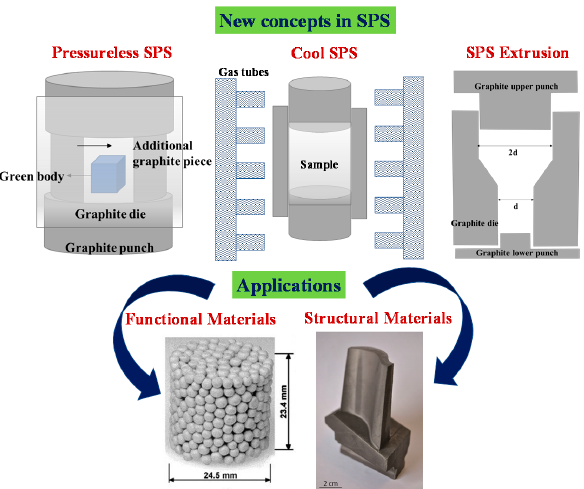
Figure 14. Schematic illustrating various new advancements in the classical SPS technique for real-life industrial applications.